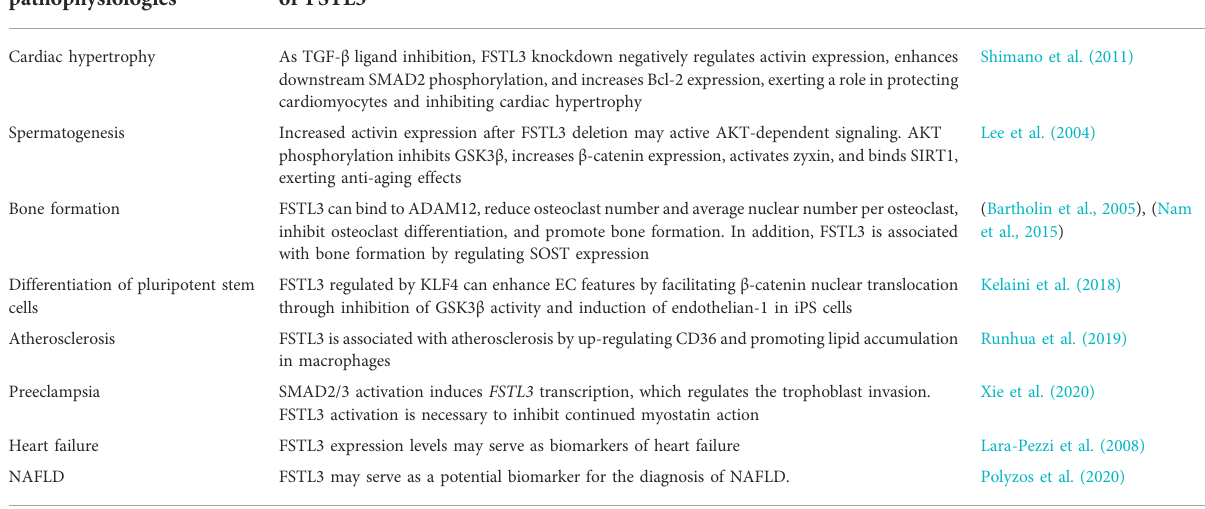
Function and mechanisms of FSTL3